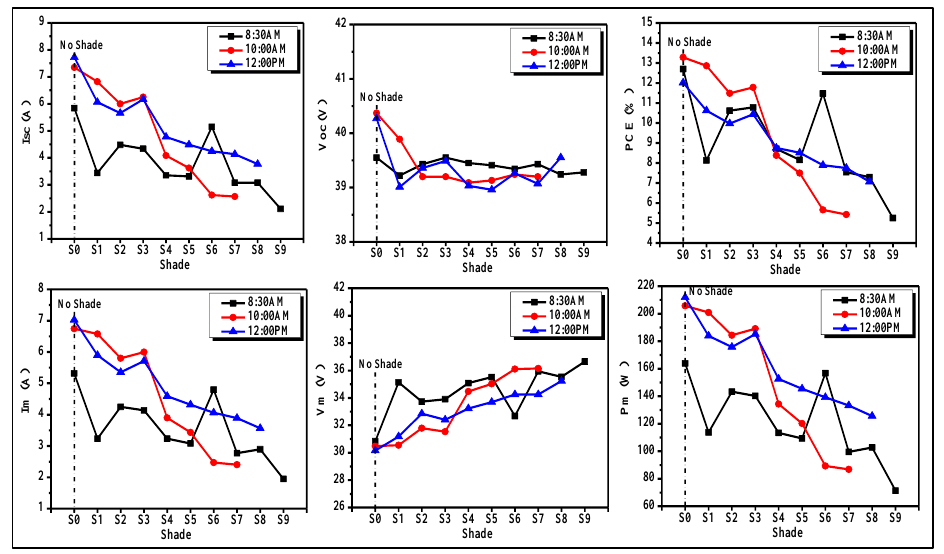
Figure 6. PV panel parameters (I